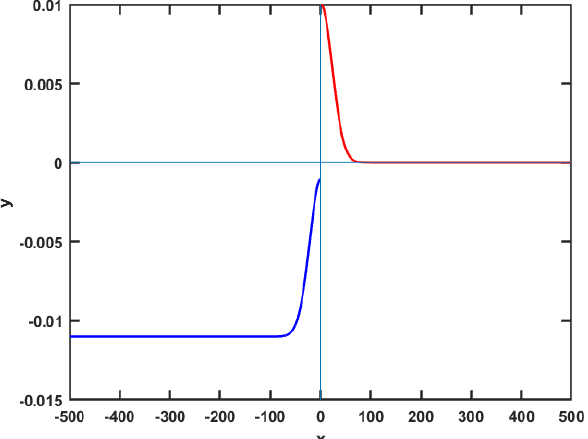
Figure 4. Graph of the function f l (considering 500 internal and external layers) with the actual constant values utilized ( c 1 = 0.01, c 2 = 0.001, c 3 = 0.011).